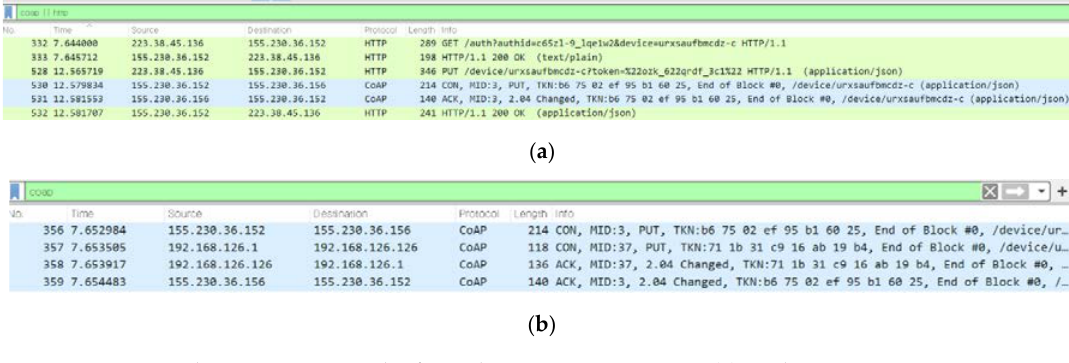
Figure 21. Packet capturing results for indirect communication: ( a ) Packet capture in IVI master, ( b ) Packet capture in IVI agent.